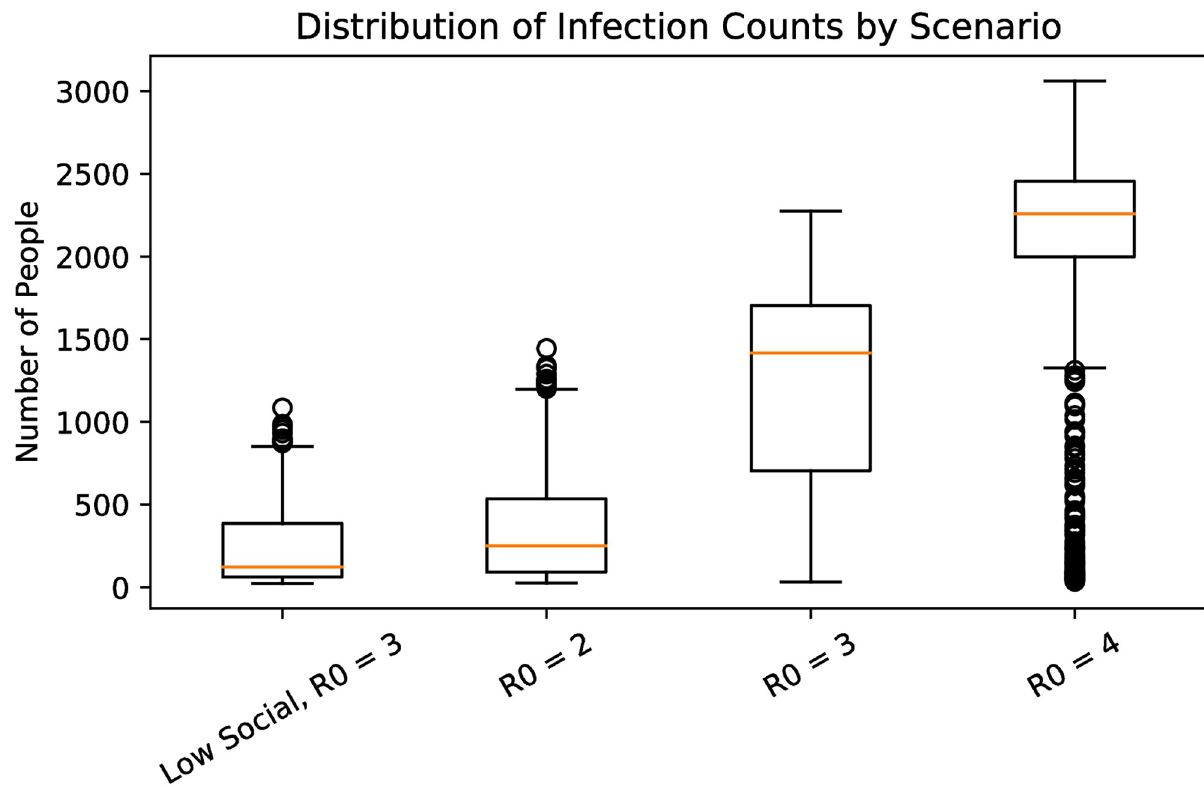
Fig 5. Total infections with R 0 = 3 and socializing as in the base model as well as the base model with R 0 = 2, 3, 4. The data is obtained from 1000 runs of each scenario.